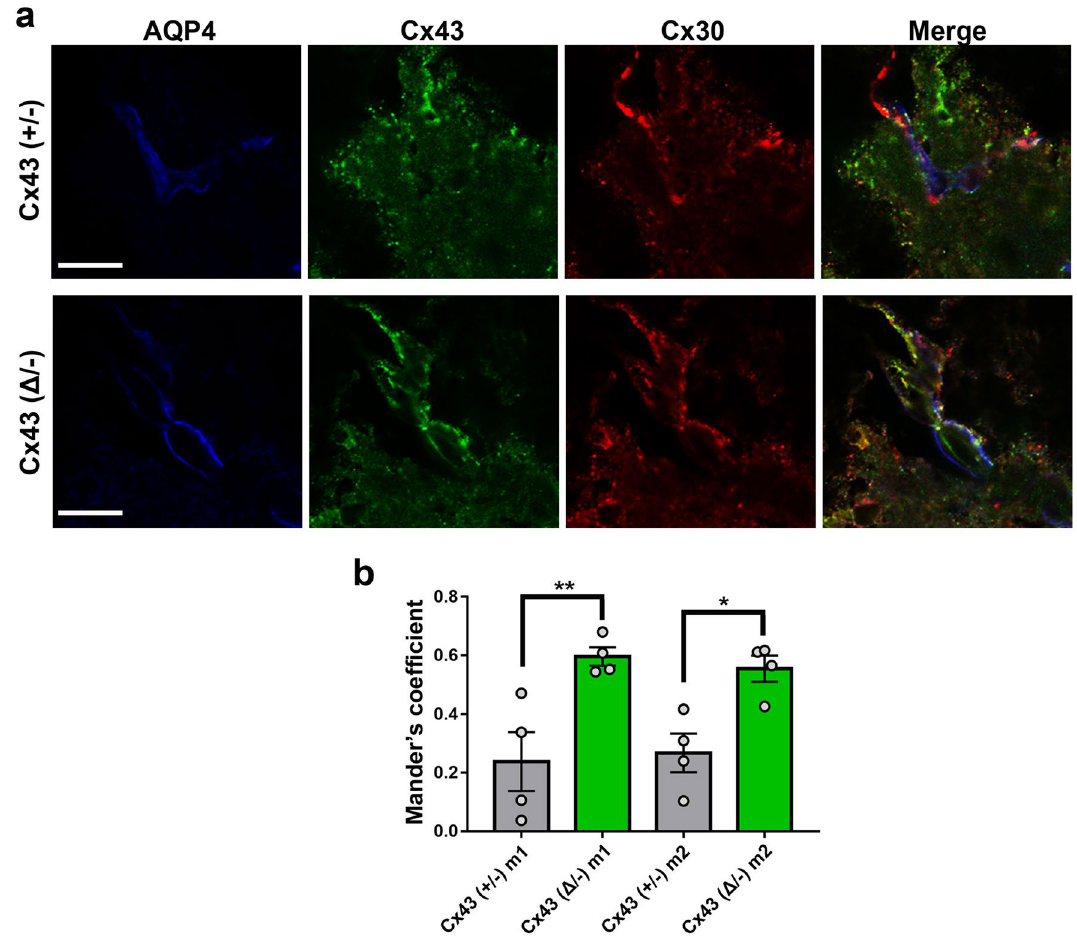
Figure 8. Higher co-localization of Cx43 and Cx30 in endfeet of Cx43 (Δ/−) than Cx43 (+/−) mouse brain. ( a ) Images showing expression of Cx43 (green) and Cx30 (red) in brain vessels of Cx43 (+/−) and Cx43 (Δ/−) mice. ( b ) Quantification of the degree of co-localization of Cx43 with Cx30 (m1) and of Cx30 with Cx43 (m2) at perivascular region of Cx43 (+/−) and Cx43 (Δ/−) mice. Note that overlap for each connexin with the other was higher in mice lacking the Cx43 carboxyl terminus. Scale bar: 100